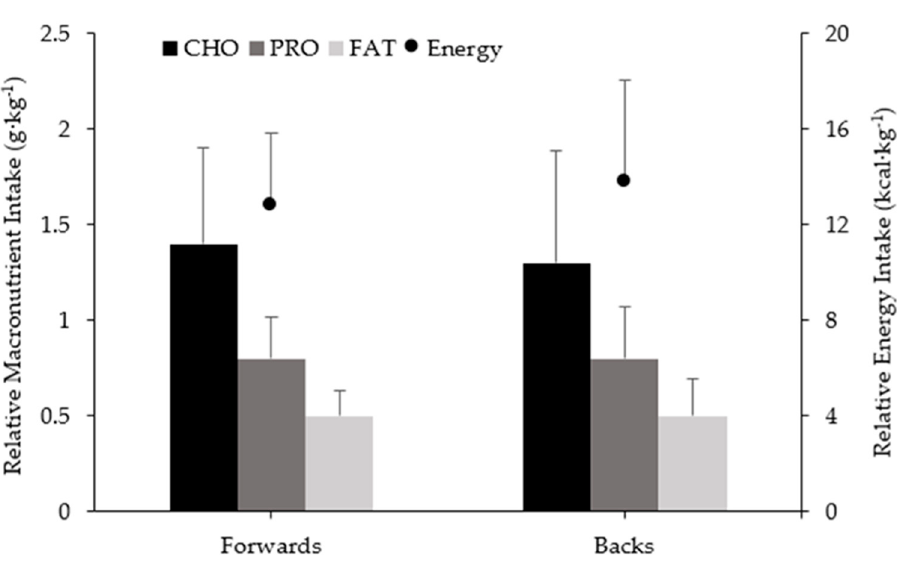
Figure 3. Relative energy and macronutrient intakes of pre-game meal 3–4 h prior to kick off among forwards and backs. CHO = carbohydrate, PRO = protein, FAT = fat. Error bars represent standard deviation. No significant differences observed ( p > 0.05).